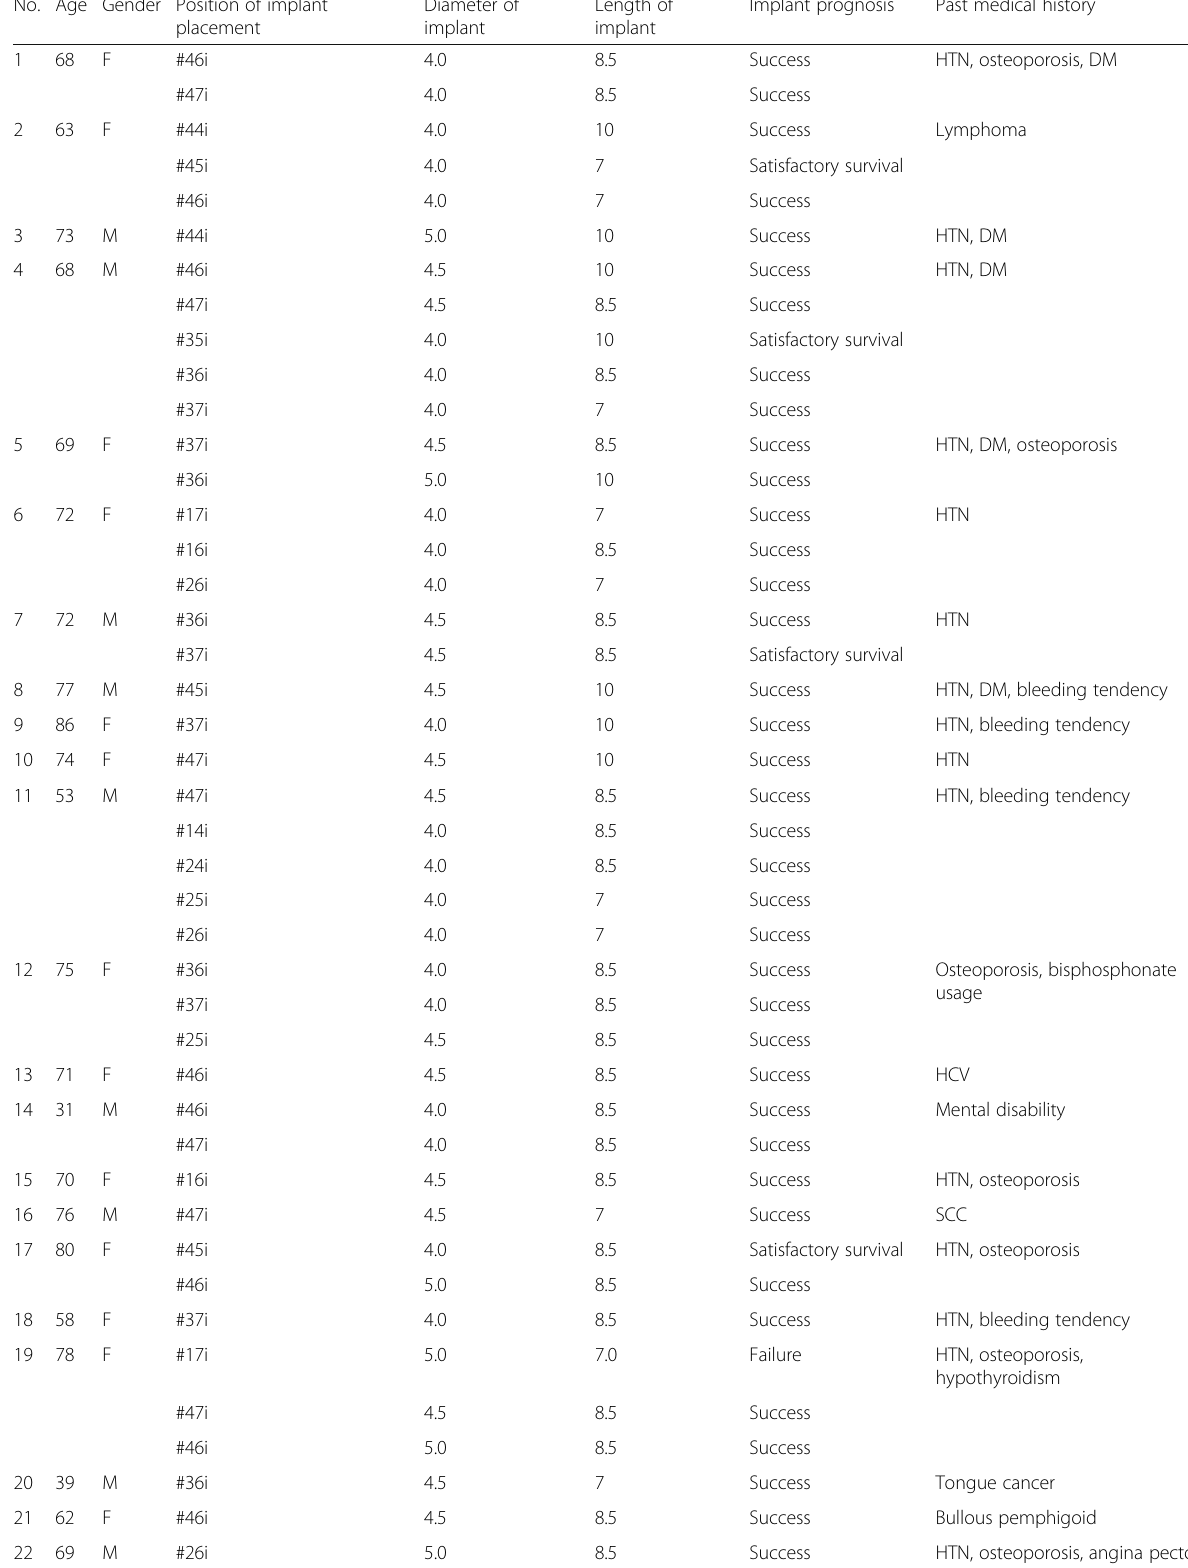
Table 1 Details of medically compromised patients No. Age Gender Position of implant